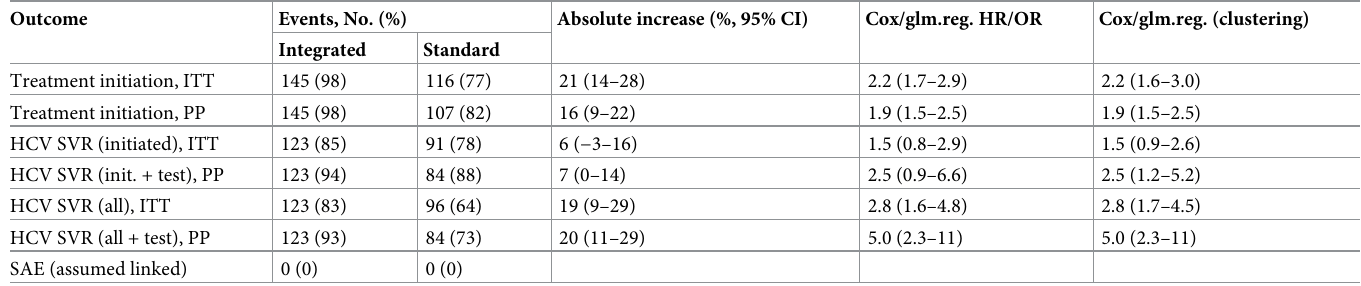
Table 2. Primary end point analysis presented for treatment initiation with both ITT and PP analyses.